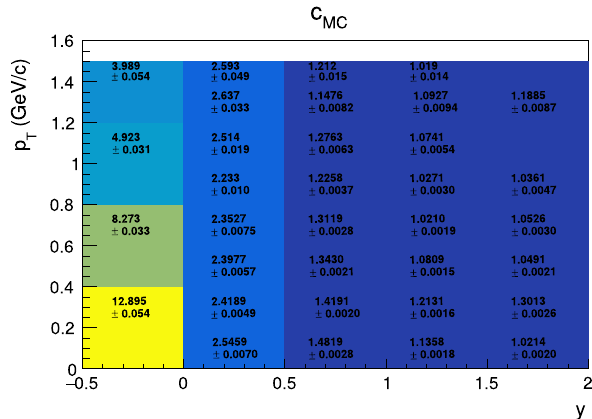
Fig. 7 Correction factors c MC with statistical